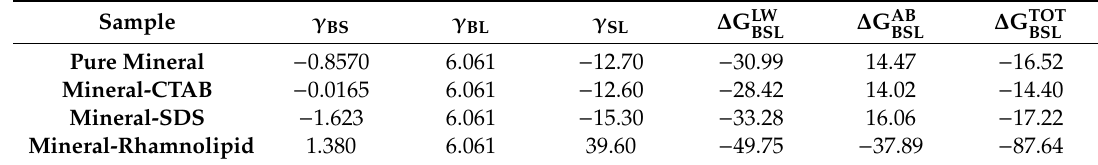
Table 4. The free energy of adhesion (mJ / m 2 ) calculated using thermodynamic theory.